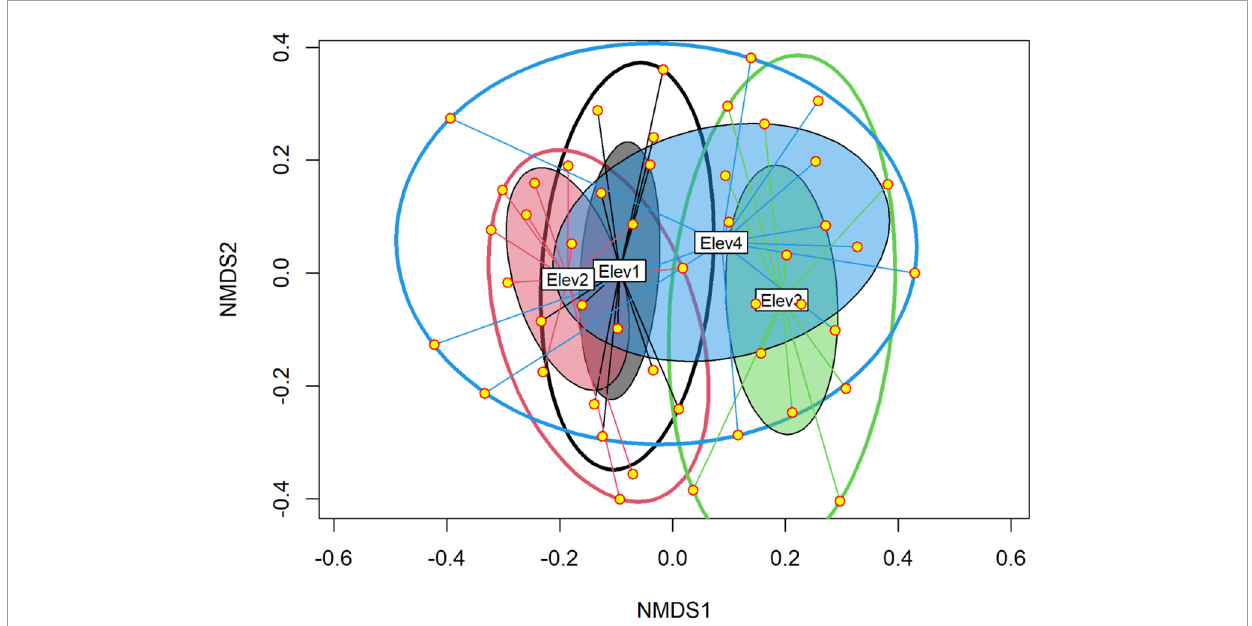
FIGURE2 Non-metric multidimensional scaling (NMDS) plot of nematode communities based on Bray–Curtis dissimilarity metric. Each point represents the position of the nematode community in ordination space based on each individual sample. The size of each ellipse is proportional to within class dissimilarity, while as the degree of overlap between the two ellipses represents similarity in nematode composition between their respective elevational classes. Elev, Elevation; where Elev1: 1,000–1,400 m, Elev2: 1,401–1,800 m, Elev3: 1,801–2,200 m, and Elev4: 2,201–2,600 m.